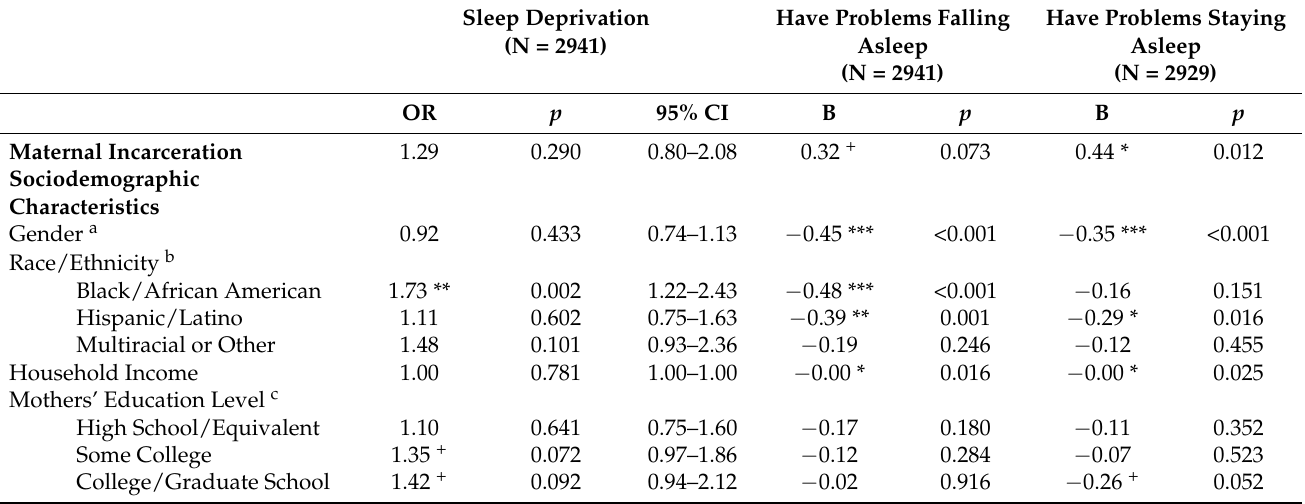
Table 3. Logistic and linear regression models on the association between maternal incarceration and adolescents’ sleep patterns,